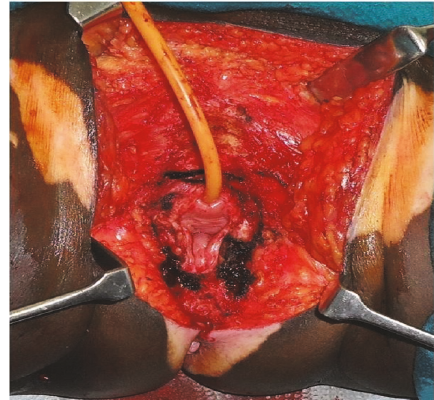
Figure 3: Simple vulvectomy.